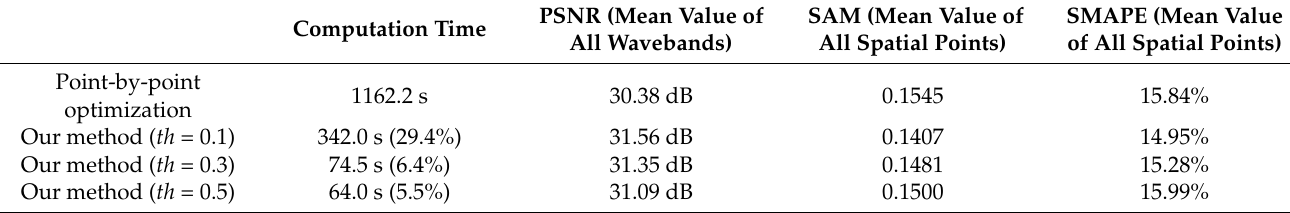
Table 1. Performance comparison for different